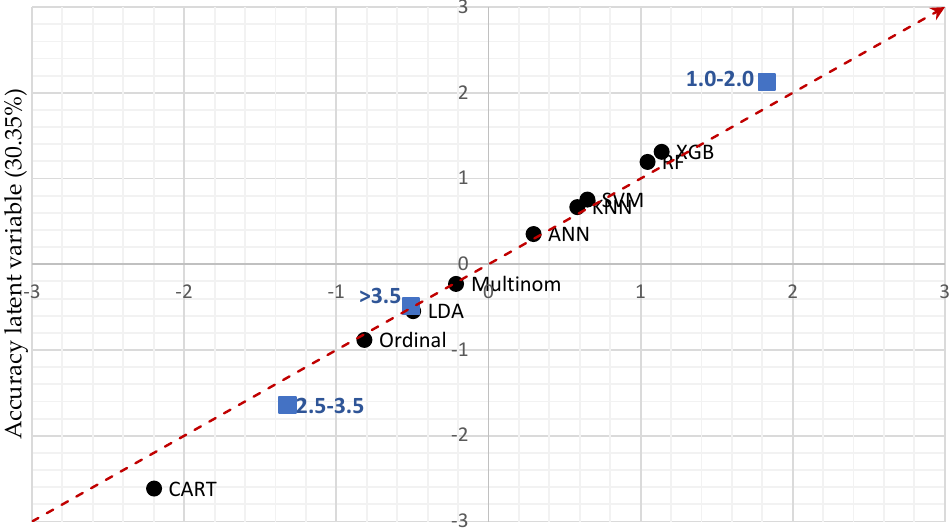
Figure 2. A plot of the accuracy and sensitivity–specificity latent variables from their first dimension/component obtained through a factor analysis of mixed variables (a combination of principle component and multiple correspondence analyses) procedure on measures of performance for the prediction of ewe BCS during pre-breeding. Dots (red sphere: model, blue square: BCS class). Dotted diagonal line indicates a balance between accuracy and sensitivity–specificity. If dot is above, then model or BCS class was more accurate than sensitive–specific, while the reverse indicates that the model was more sensitive than accurate. The further and more positive a model is along the diagonal line, the greater and better its prediction power. The variance explained by each extracted first dimension for each latent variable (accuracy, sensitivity–specificity) is given in parenthesis along the axes.